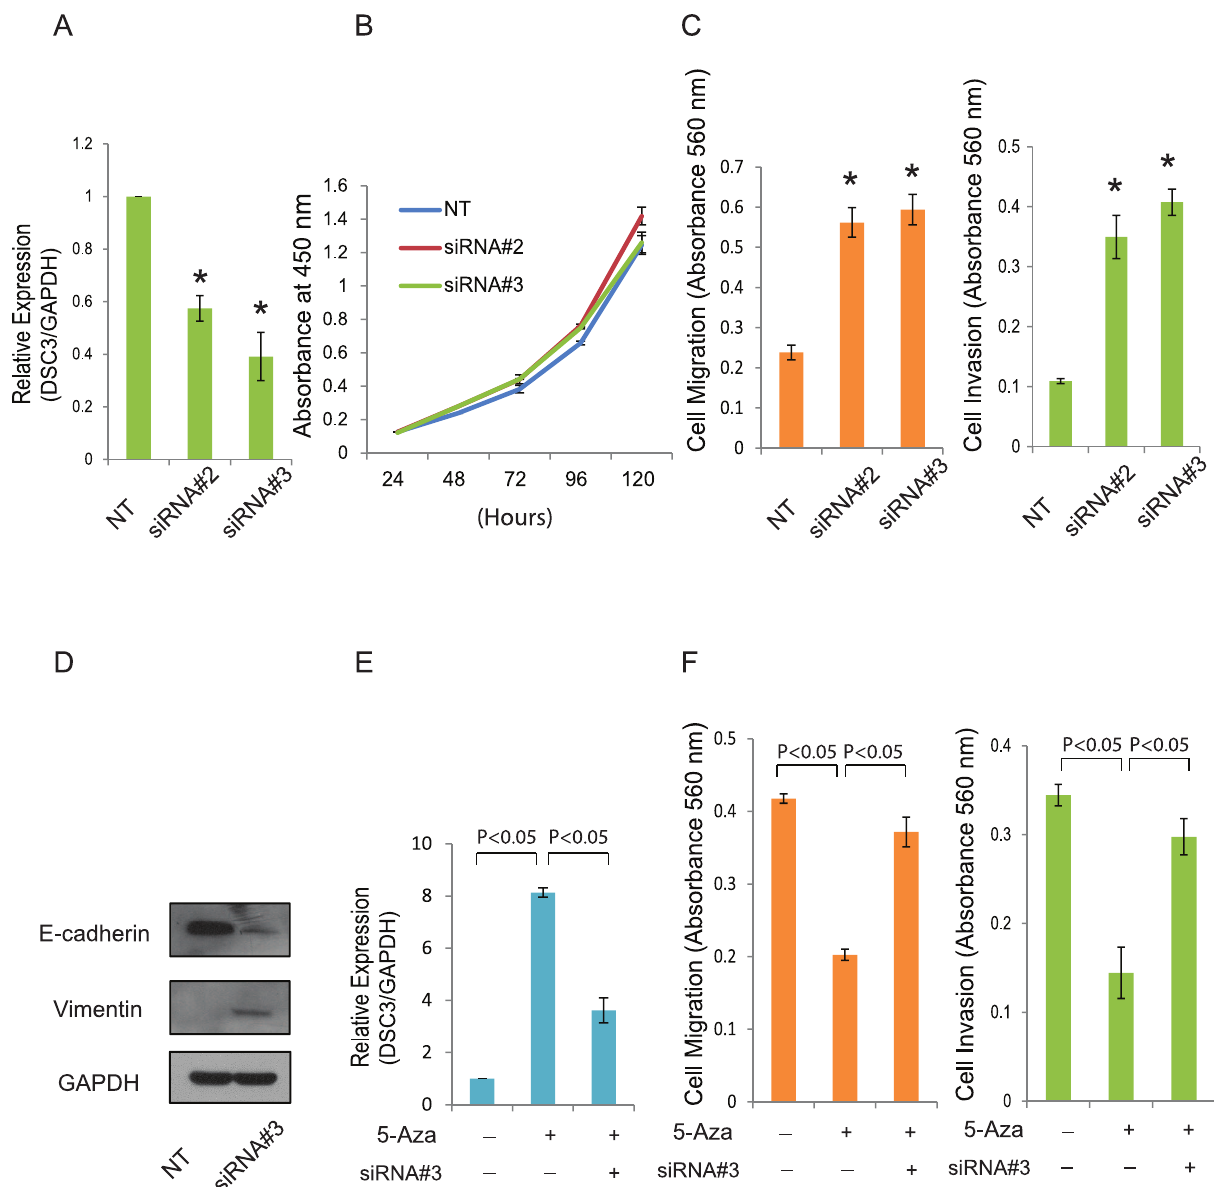
Figure 5. Effect of DSC3 on the Migration/Invasion Potential of Prostate Cells. (A) DSC3 knockdown by siRNA in benign prostate cell line RWPE as detected by Q-PCR.*indicates values that are significantly different than the Non-Target group (NT). siRNA # 2 and siRNA # 3 are two individual DSC3 siRNA. (B) Effect of DSC3 knockdown on proliferation in RWPE cells by WST-1. (C) Effect of DSC3 knockdown on migration through Transwell and invasion through Matrigel in RWPE cells. Migrated and invaded cells were stained with crystal violet, solubilized and quantitated by measuring absorbance at 560 nm.*indicates values that are significantly different than the Non-Target group (NT). (D) E-cadherin and Vimentin expression assessed by Western blot analysis in RWPE cell treated with Non-Target siRNA or DSC3 siRNA. (E) Q-PCR for DSC3 using total RNA extracted from PCa cell line Du145 treated with 5-Aza or DSC3 siRNA. (F) The migration and invasion potential of the untreated and 5-Aza treated Du145 were assessed by Transwell or Matrigel assay. Migrated and invaded cells were stained with crystal violet, solubilized and quantitated by